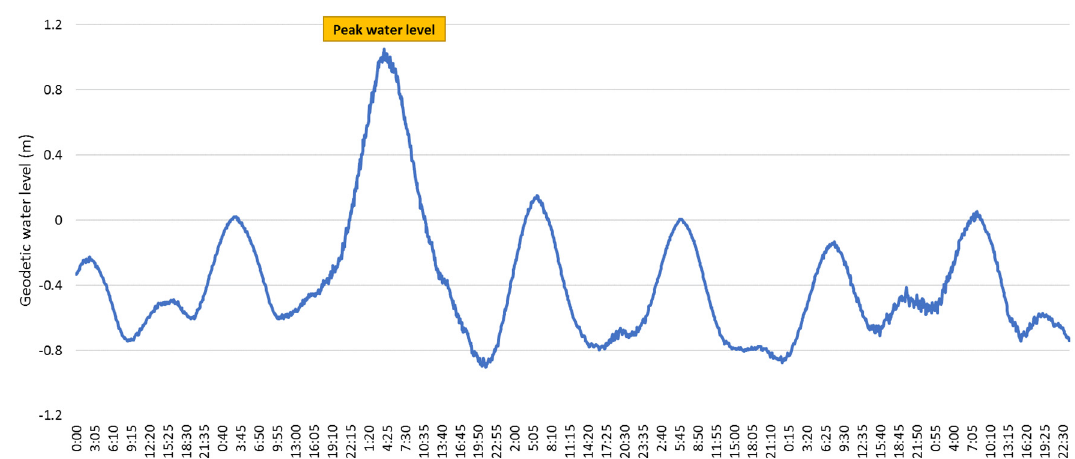
Figure 9. Observed tide gauge water levels in Tignish from 6 to 12 September 2019. of 1.68 m geodetic at 00:30 on 8 September, indicating that the peak at this location was